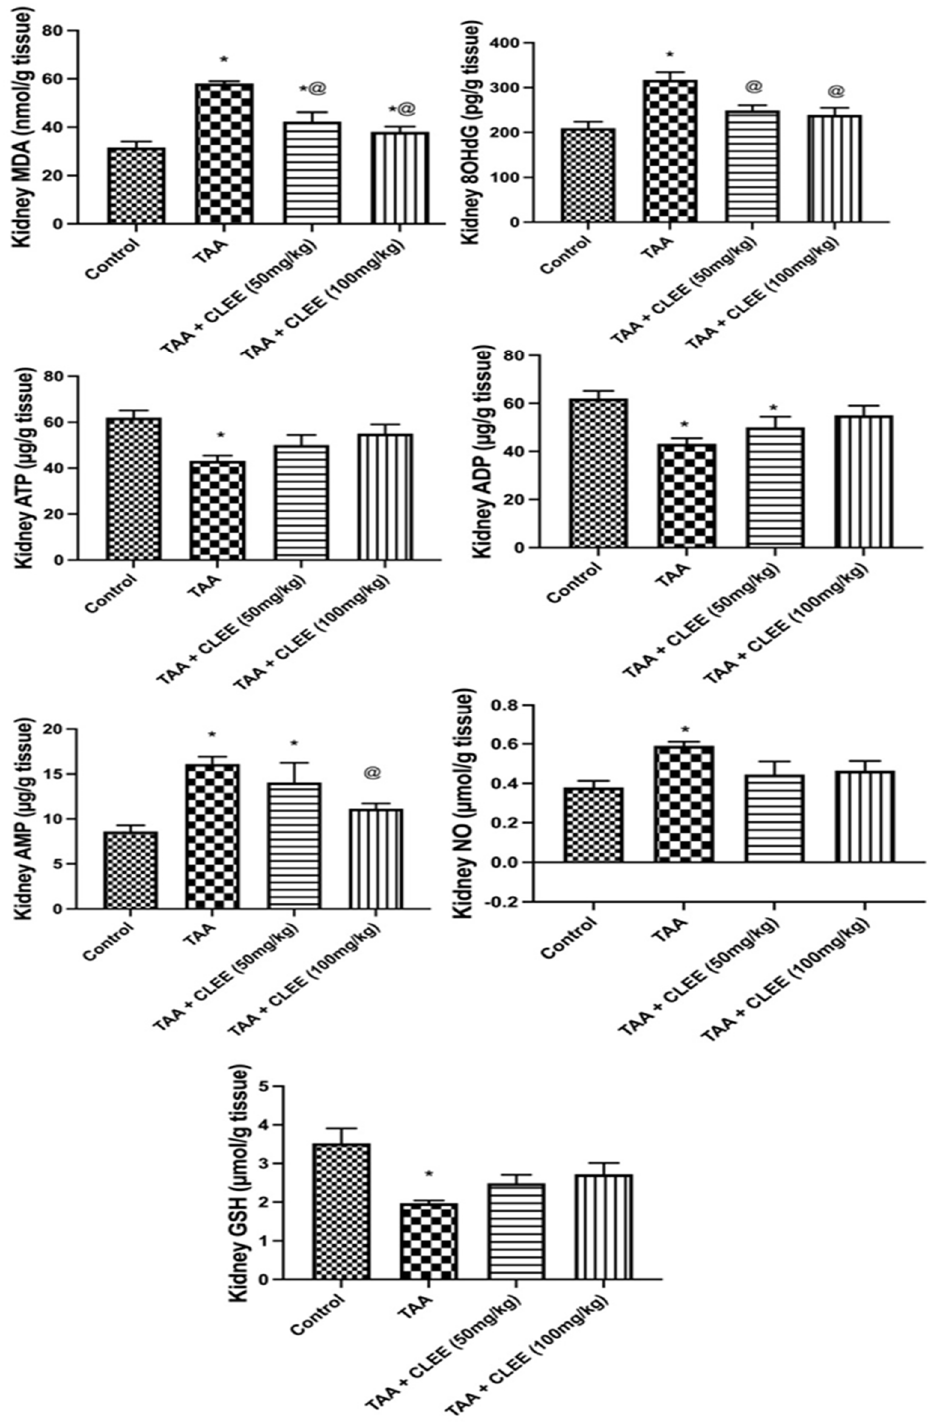
Figure 7. Effect of C. laevigatus EtOH extract (CLEE) on renal oxidative stress and energy parameters of rats intoxicated by TAA. Each value represents the mean of six animals ± SE. Statistical analysis was performed using one-way ANOVA followed by the Tukey-Kramer multiple comparisons test. (* vs. control group, and @ vs. TAA group) at p < 0.05.